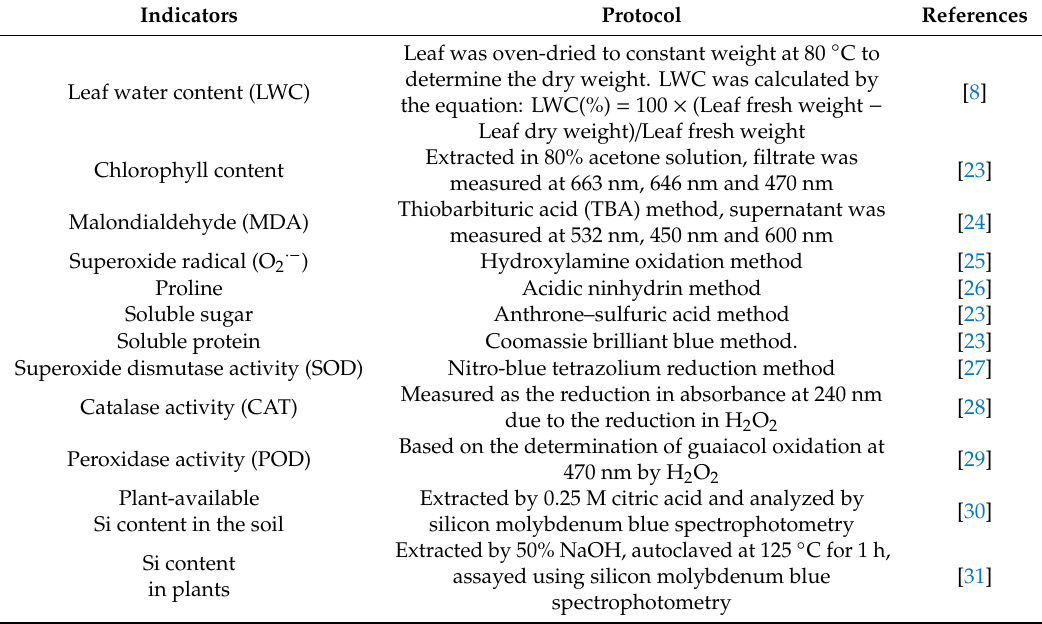
Table 1. Protocol measurements for the indicators selected in this